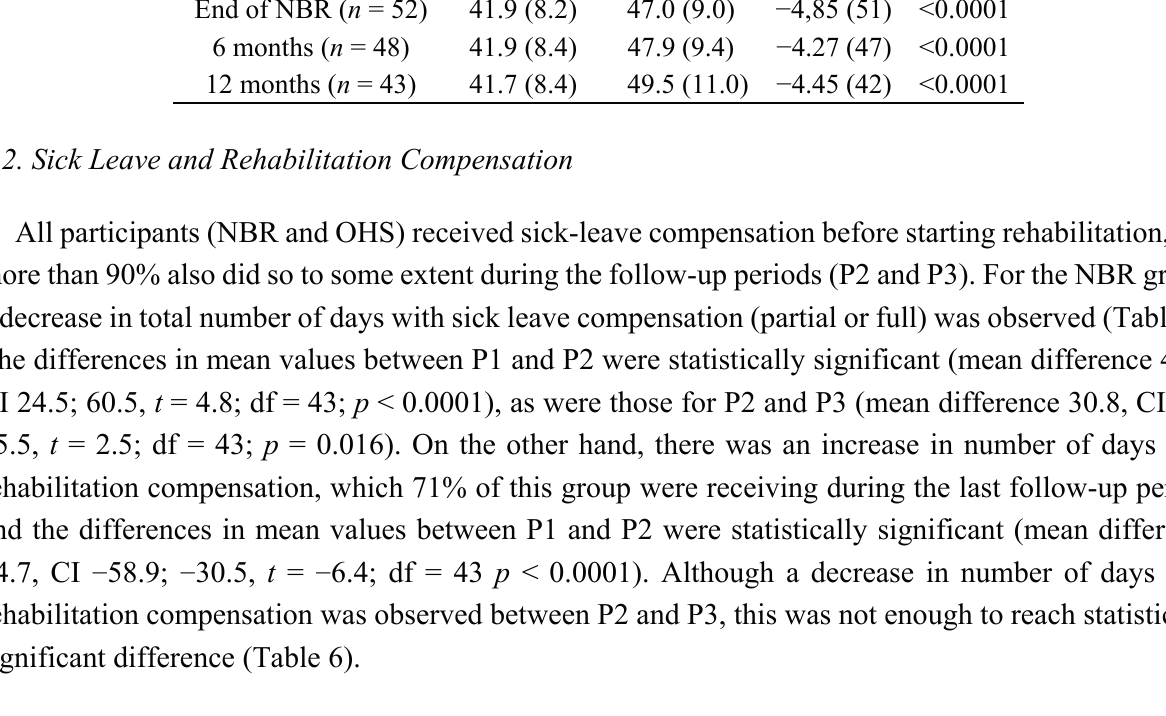
Table 5. Comparison of mean differences for PGWB score; comparing start of NBR with follow-up at the end of NBR and at six- and twelve-month follow-up, respectively. Start Follow-Up Length of Follow-Up t(df) p -value Mean (SD) Mean (SD) PGWB 4 Score End of NBR ( n = 52) 41.9